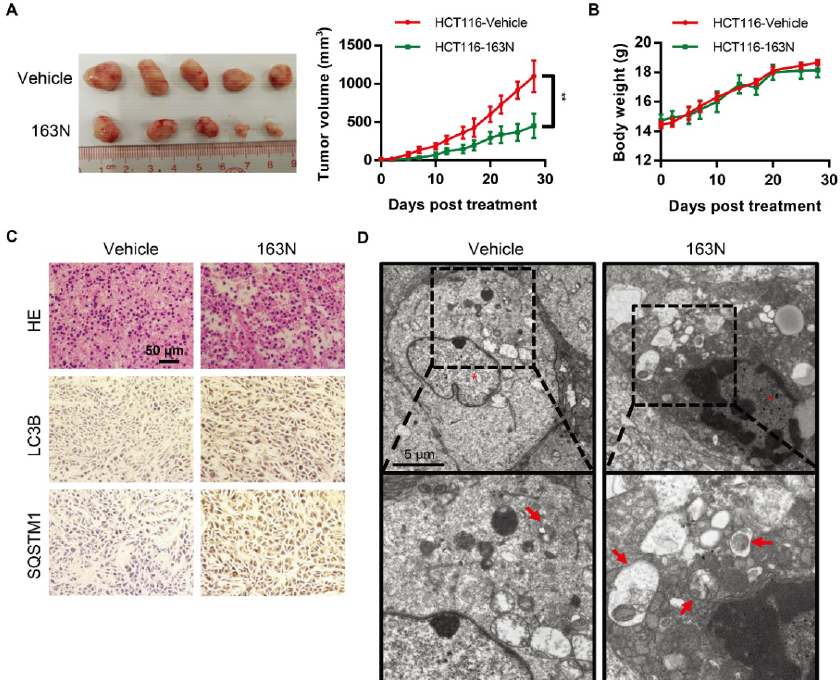
Figure 7. 163N inhibits tumor growth in a HCT116 mouse xenograft model. ( A ) HCT116 cells (3 × 106) were injected subcutaneously into the right flank of the immunodeficient nu / nu female mice. Seven days after tumor cell implantation, mice with palpable tumors were divided randomly into two groups and injected intraperitoneal on Monday, Wednesday, and Friday with either corn oil vehicle or 163N (50 mg/kg). Tumor volumes were calculated by the length and width measured by Vernier calipers every 2 d. ( B ) Body weight changes of mice during 28 d of exposure. ( C ) Tumor tissues were sectioned and subjected to H&E staining and immunohistochemistry for evaluating histological morphology, and expression of LC3B and SQSTM1. Scale bar: 50 µ M. ( D ) TEM was used to detect the ultrastructure of the representative tumor tissues. Red arrows represent normal autolysosome structures. Data are presented as mean ± SEM. ** p < 0.01 vs